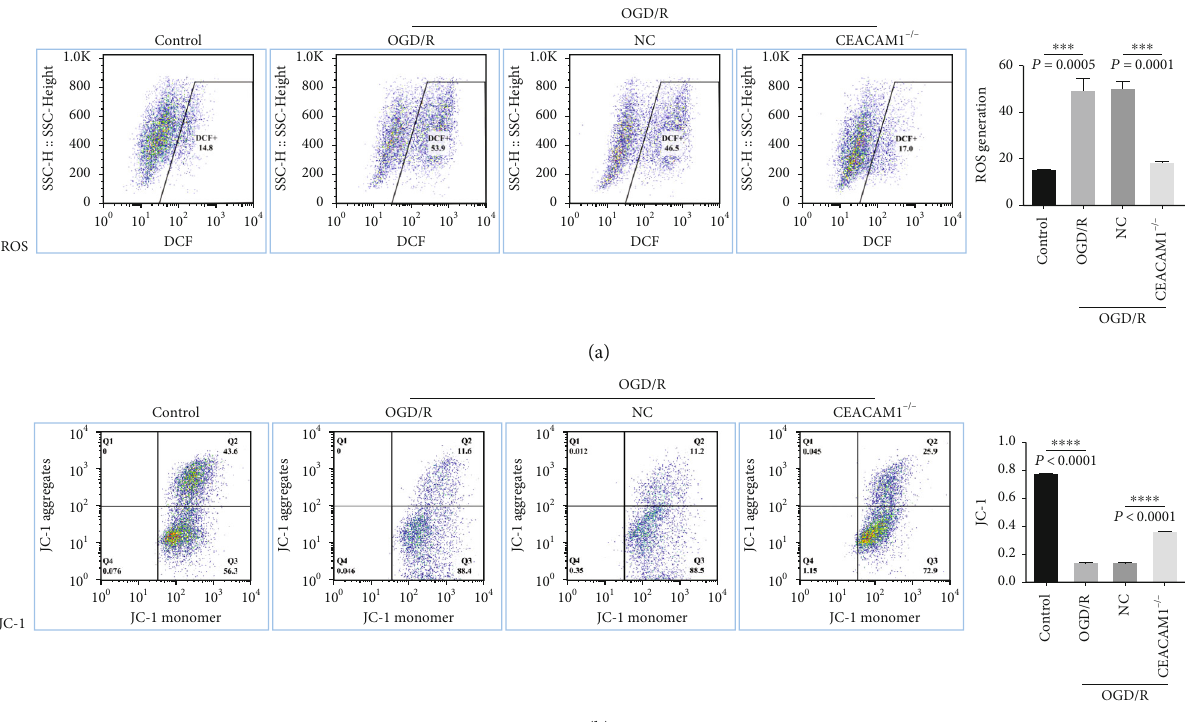
Figure 3: Reduction of CEACAM1 expression in HPVMECs reducing response of ROS generation and increasing mitochondrial membrane in response to hypoxic conditions. (a) Changes in cellular ROS levels in HPVMECs with and without CEACAM1 subjected to OGD/R. (b) JC-1 expression in control and CEACAM-/- HPVMECs under normal and OGD/R